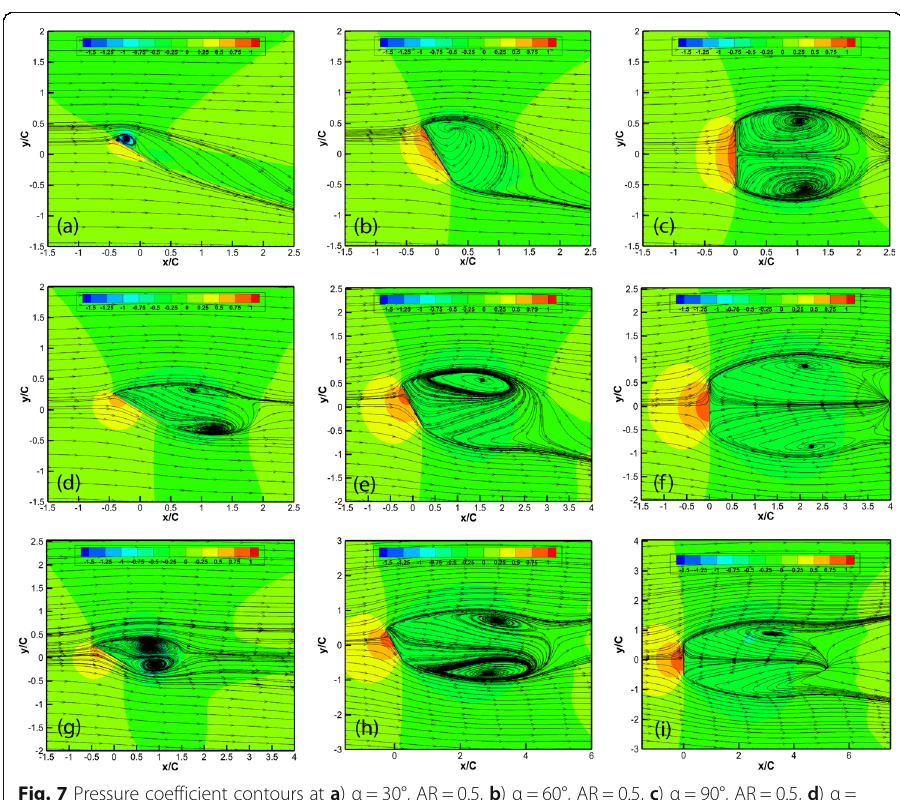
Fig. 7 Pressure coefficient contours at a ) α = 30°, AR = 0.5, b ) α = 60°, AR = 0.5, c ) α = 90°, AR = 0.5, d ) α = 30°, AR = 2, e ) α = 60°, AR = 2, f ) α = 90°, AR = 2, g ) α = 30°, AR = 5, h ) α = 60°, AR = 5, i ) α = 90°, AR =